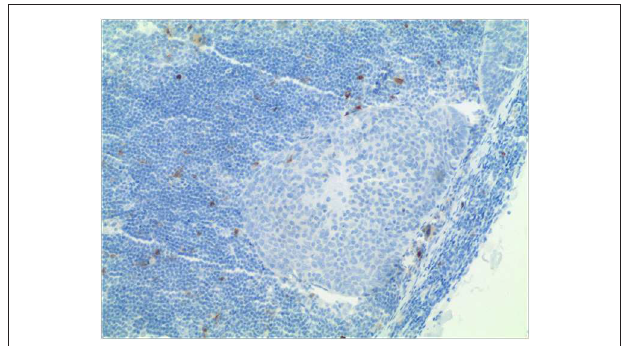
FIGURE 1 | Negative result of p16 in immunohistochemical analysis (HE staining ×